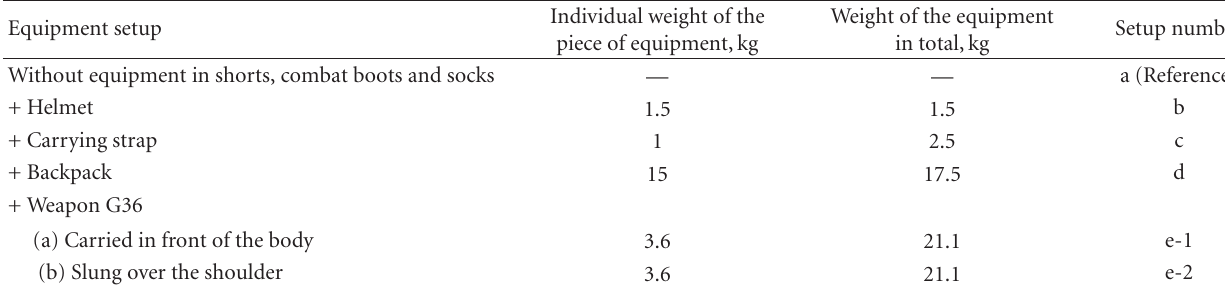
Figure 1: Equipment in order of investigation: (a) reference, (b) helmet, (c) load-carrying strap, (d) backpack, (e-1) rifle (in front of the body), and (e-2) rifle (slung over the right shoulder). Table 1: Weight of di ff erent equipment items used in the